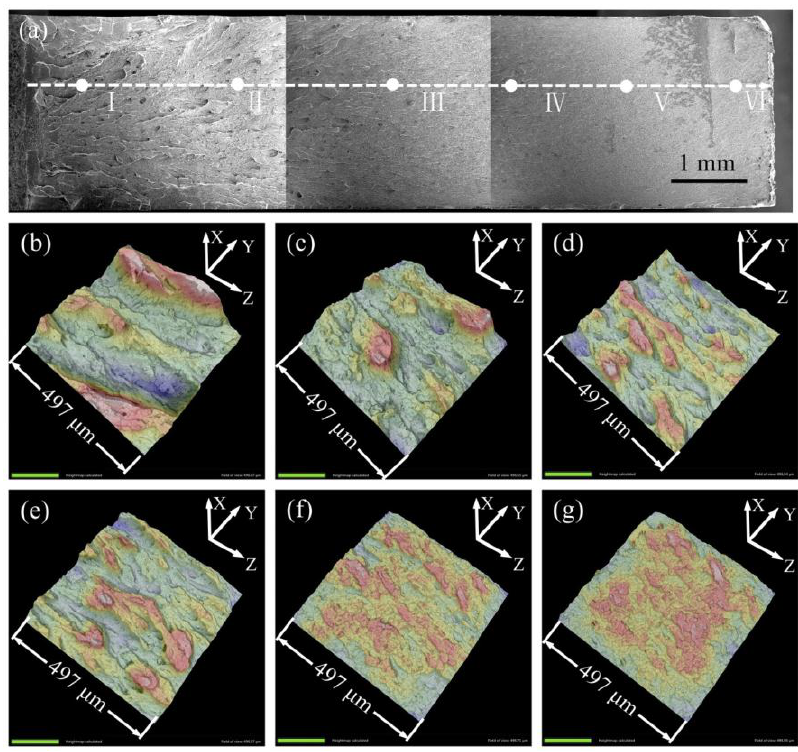
Figure 4. Representative fractographic evolution for the MG. ( a ) Overview (arrow indicates the crack propagation direction); ( b – g ) 3D fractographies at points I, II, III, IV, V and VI in ( a ), respectively.